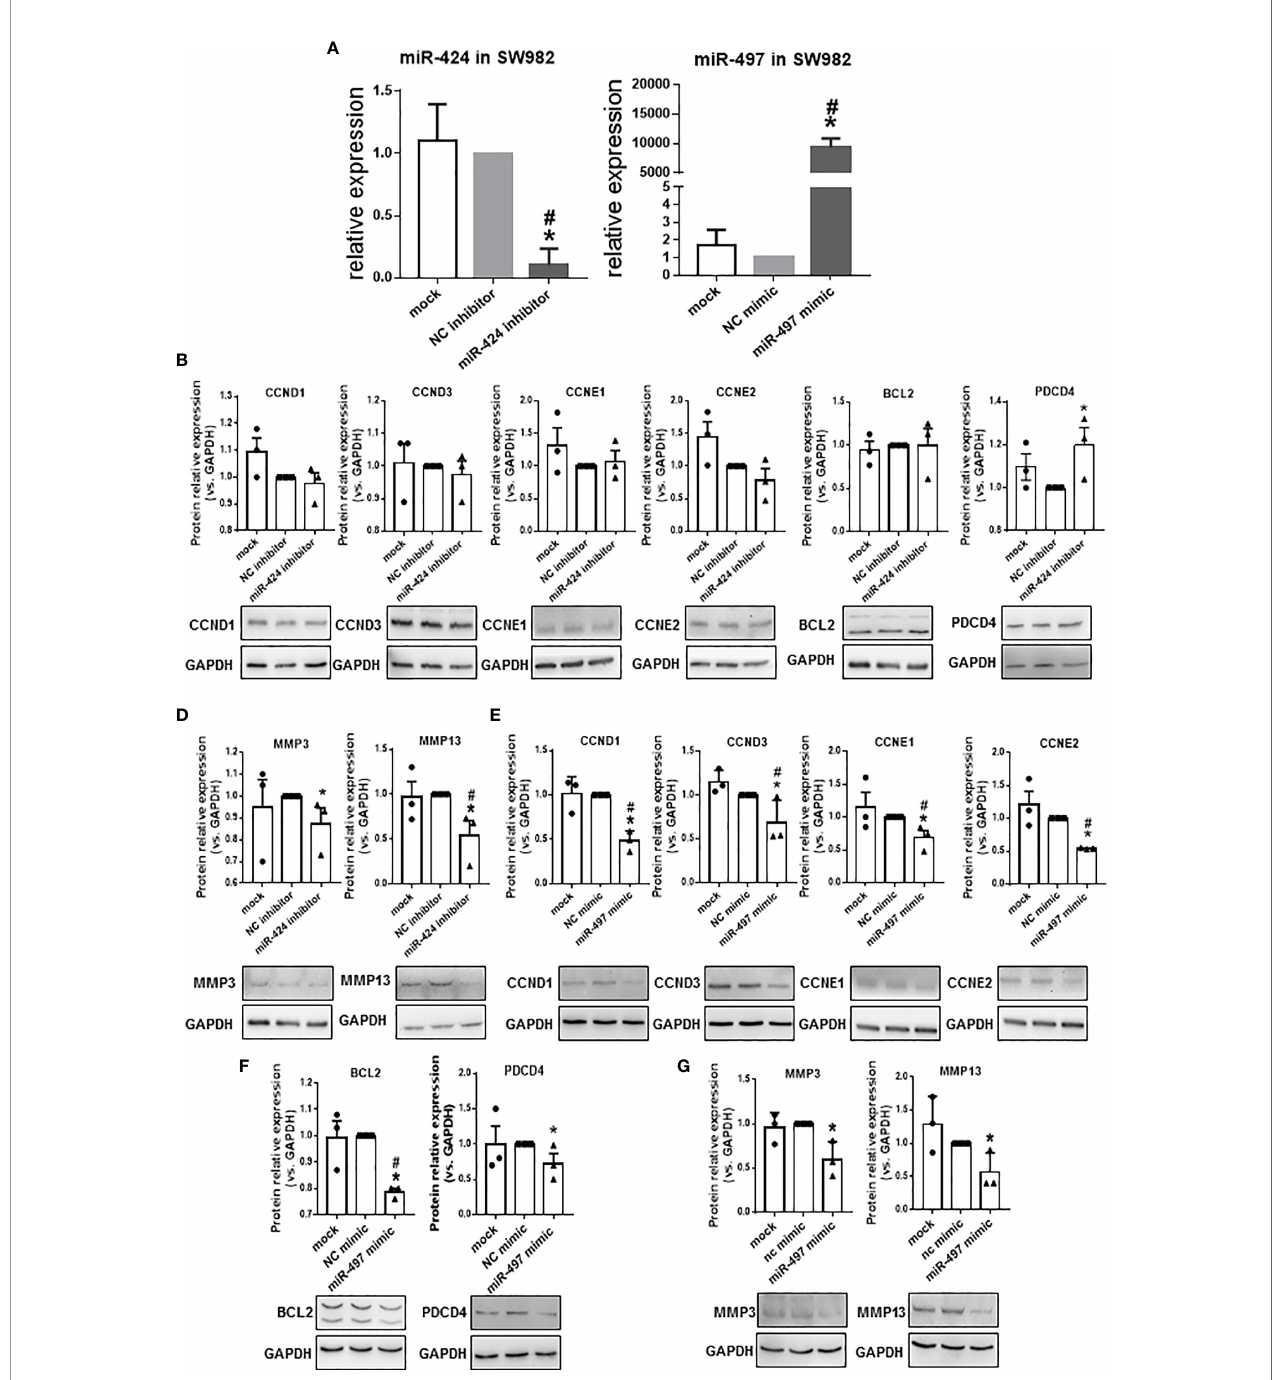
FIGURE 3 | Expression of proliferation, apoptosis, and extracellular matrix degradation related genes at protein level in SW982 cells. (A) The expression of miR-424 and miR-497 determined by using RT-qPCR from SW982 cell transfected with 100 nM miR-424 inhibitor or 10 nM miR-497 mimic for 48h. (B – D) Western blotting results of CCND1, CCND3, CCNE1, CCNE2 (B) , BCL2 and PDCD4 ( C ), MMP3, and MMP13 (D) in 100 nM miR-424 inhibitor-treated cells. (E – G) Western blotting result of CCND1, CCND3, CCNE1, CCNE3 (E) , BCL2 and PDCD4 (F) , MMP3 and MMP13 (G) in 10 nM miR-497 mimic-treated cells. Bar: mean ± SEM from three independent cell experiments in SW982 cell. Triplicates were used for each transfection and RT-qPCR experiment. P <0.05, *: vs. NC, #: vs. mock using Mann- Whitney